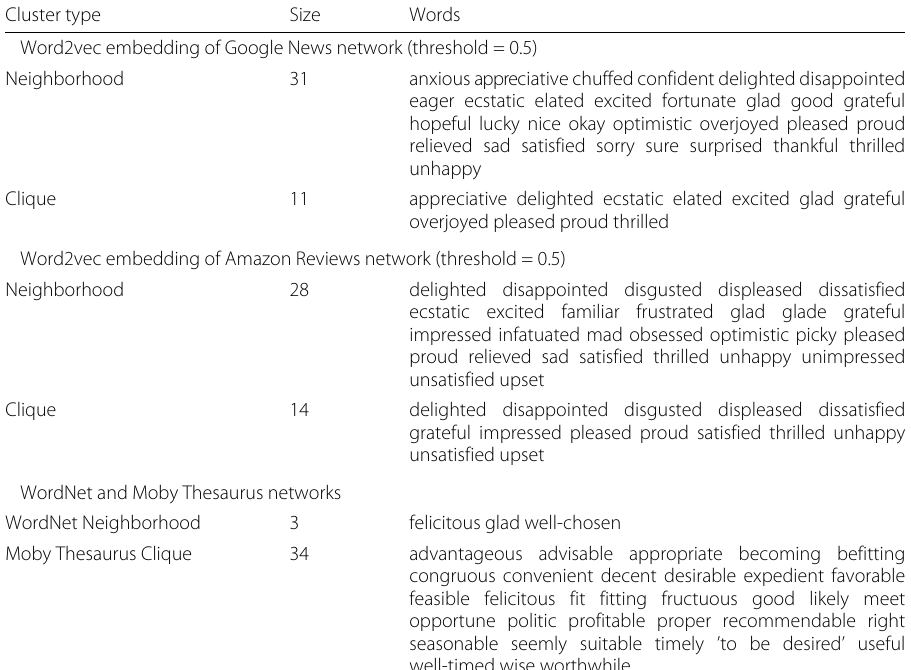
Table 7 Neighborhood of the word ‘happy’ and the largest cliques in the corresponding neighborhoods in the considered networks Cluster